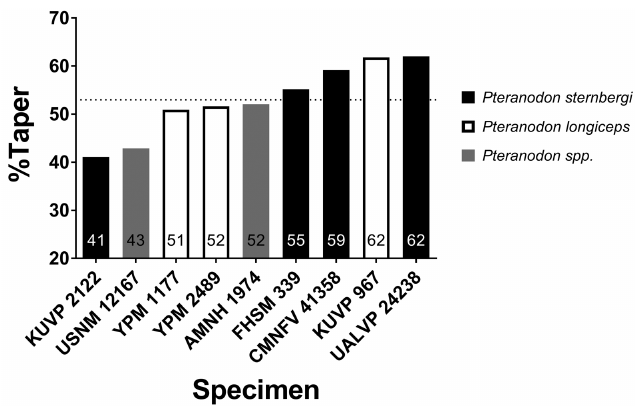
Figure 9. Comparisons of the percent rostral tapers of Pteranodon specimens. Asterisk indicates that basal height was measured from the basalmost portion of the rostral specimen, since the anterior margin of the nasoantorbital fenestra is not preserved. FHSM 339, the type of P. sternbergi , is shown in grey, since the rostrum of this specimen is largely